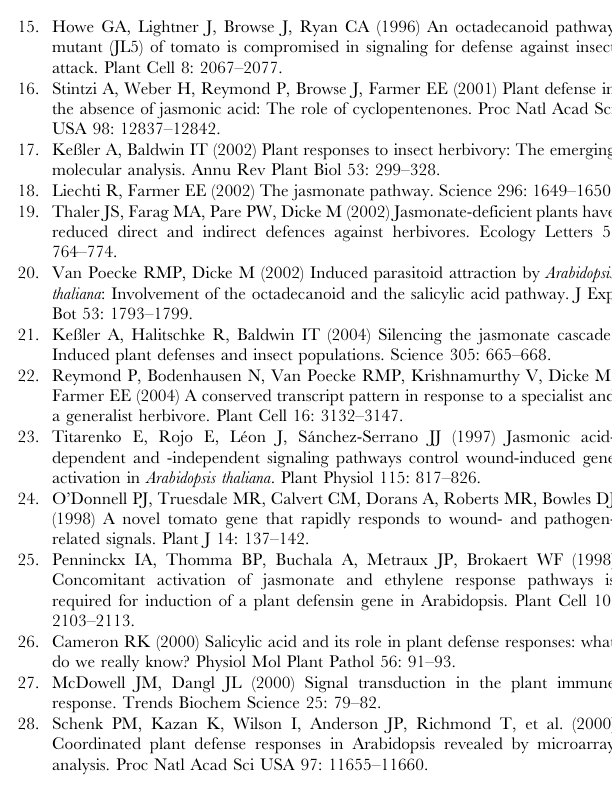
Table S4 cDNAs with significant differential regulation in B. divaricarpa experiments. ‘Gene’ refers to pairs of features on the custom macroarray, while the ‘TAIR identifier’ (www.arabidopsis. org) is based on the best BLAST match of a given sequence from this macroarray. ‘Source’ gives the origin of a cDNA, together with a description of the corresponding gene. ‘F-RatioTRT’ quantifies statistical significance for differences in transcript levels between treatments. Furthermore, normalized data for controls (‘C’), wounding (‘W’), herbivory by P. xylostella (‘ID’), herbivory by T. ni (‘IT’), ethylene (‘E’), jasmonic acid (‘JA’), and salicylic acid (‘SA’) treatments are given for t=45 min (‘45’), 3 hours (‘3’), 9 hours (‘9’), and/or 24 hours (‘24’). Data normalization and transformation procedures are described in MATERIALS AND METHODS. ‘ID9/W9’ and ‘IT9/W9’ indicate transcript level ratios for herbivory by P. xylostella or T. ni vs. wounding at 9 hours.